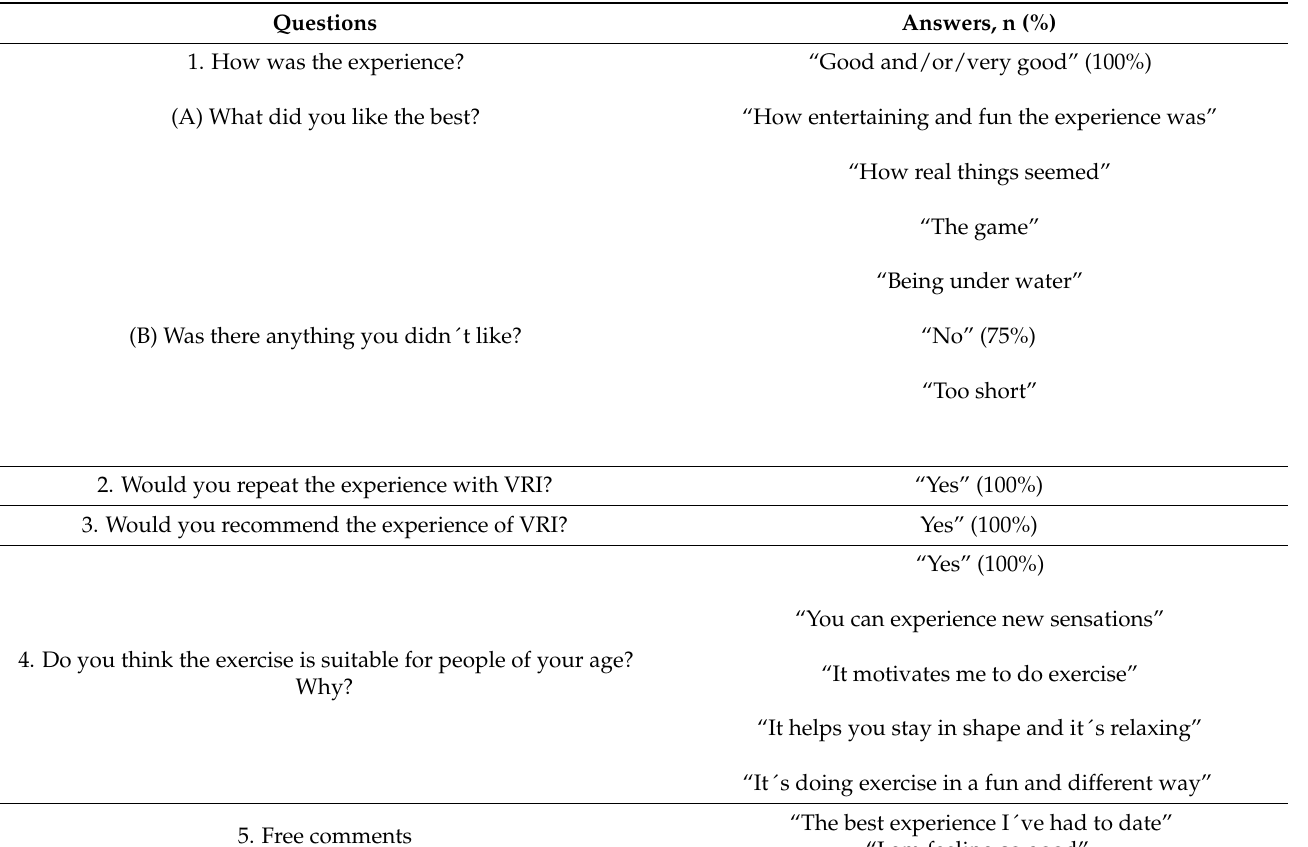
Table 4. Satisfaction ad hoc